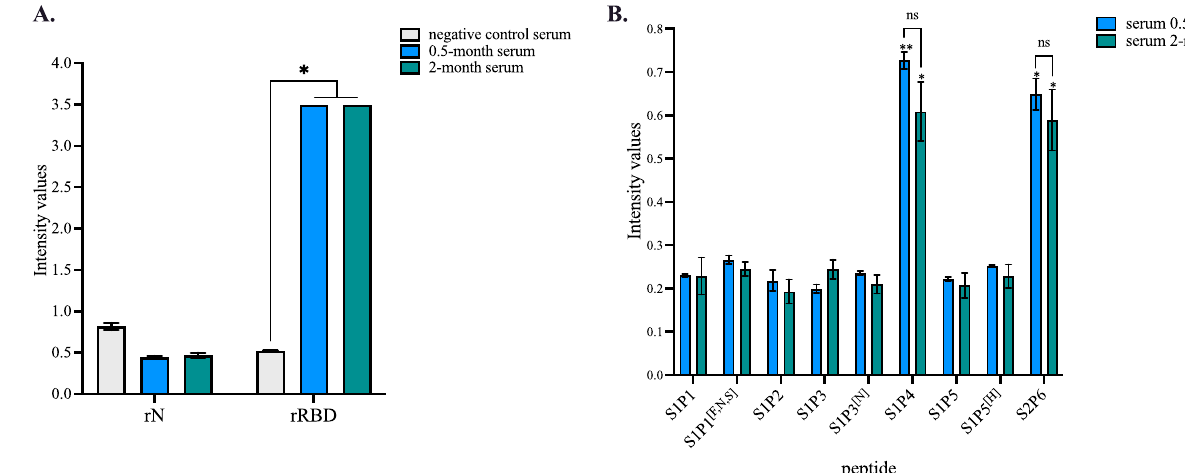
Figure 3. Antigenic reactivity of synthetic peptides with comirnaty vaccine recipient sera. Serum samples from an infection-naïve individual who received comirnaty vaccine in a 2-dose regimen were collected at 0.5 month or 2 months after the injection of a second dose. A pool of ten infection-naïve individuals collected in 2019 (Table S3) served as negative control serum. In ( A ), serum samples at dilution 1:100 were assessed for the detection of antibodies against SARS-CoV-2 N and S proteins by indirect ELISA using soluble rN and rRBD proteins for antigen-based antibody capture. The intensity values of serum samples were measured at O.D. 450 nm. The results are the mean (± SEM) of three replicates. Statistical comparisons were performed between serum samples. Statistically significant comparisons are shown as * p < 10 –4 (ns: non-statistically significant, p > 0.05). In ( B ), the serum samples were assayed at dilution 1:50 on synthetic peptides and their variants (200 ng.ml −1 ) through synthetic peptide-based ELISA. The intensity values of vaccine serum sample were measured at O.D. 450 nm. The results are the mean (± SEM) of three replicates. Pairwise comparisons between peptides showed that the experimental points for S1P4 and S2P6 peptides are significantly different from the other peptides (** p < 10 –4 , * p < 10 –3 ). The differences between 0.5 month and 2.0 month for the synthetic S1P4 and S2P6 peptides are non-statistically significant (ns, p >